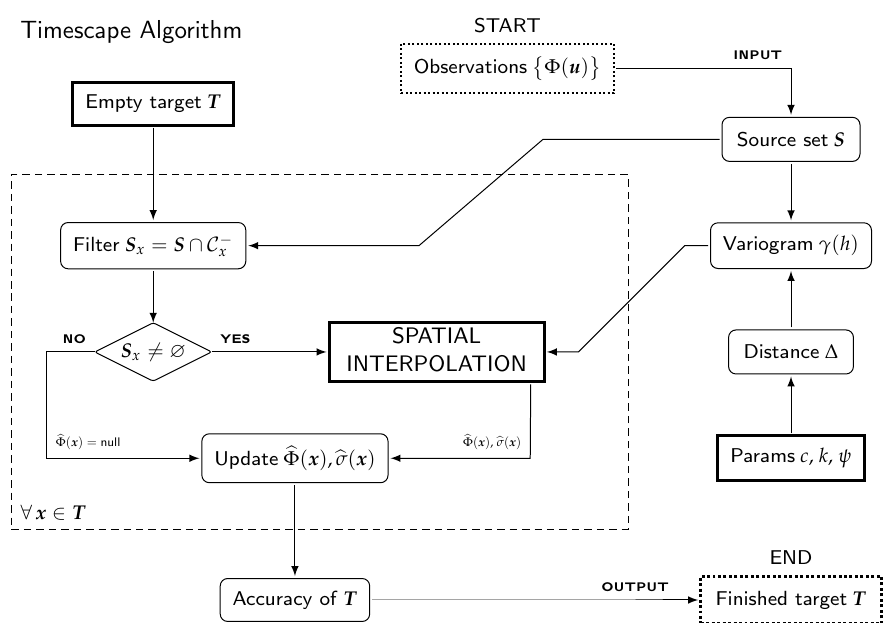
Figure 8. Timescape flowchart. Users must choose a target set T , a spatial interpolator, the distance parameters c and k , and form factor ψ (thick boxes). The accuracy can be evaluated by the spatial interpolator itself or a posteriori, depending on the chosen spatial interpolator.